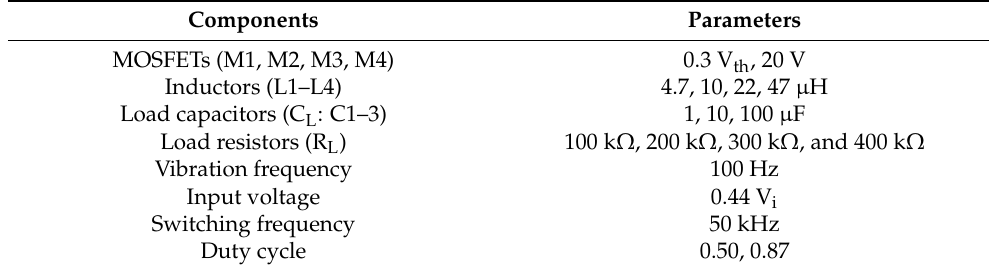
Figure 11. An experimental setup and its flowchart ( a ). Experimental setup, ( b ). Proposed circuit cuit with individual experimental devices, (1) Function generator, (2) Amplifier, (3) Mechanical with individual experimental devices, (1). Function generator, (2). Amplifier, (3). Mechanical shaker, shaker, (4, 5, 6) PD, Aluminium beam, Proof mass, (7, 8) INLSC, 7-segment display, (9) Oscilloscope, (4, 5, 6). PD, Aluminium beam, Proof mass, (7, 8). INLSC, 7-segment display, (9). Oscilloscope, (10). Ammeter, Voltmeter. (10) Ammeter, Voltmeter. Table 1. Parameters of various components used in the